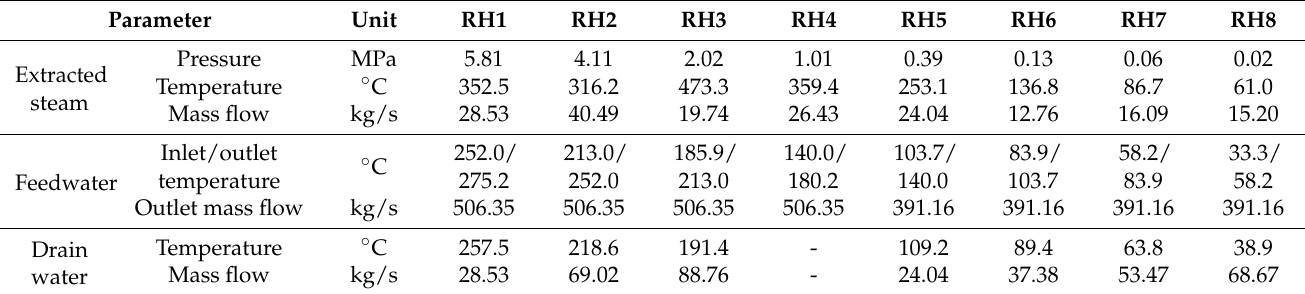
Table 4. Parameters of the regenerative steam extraction system of CFPU.